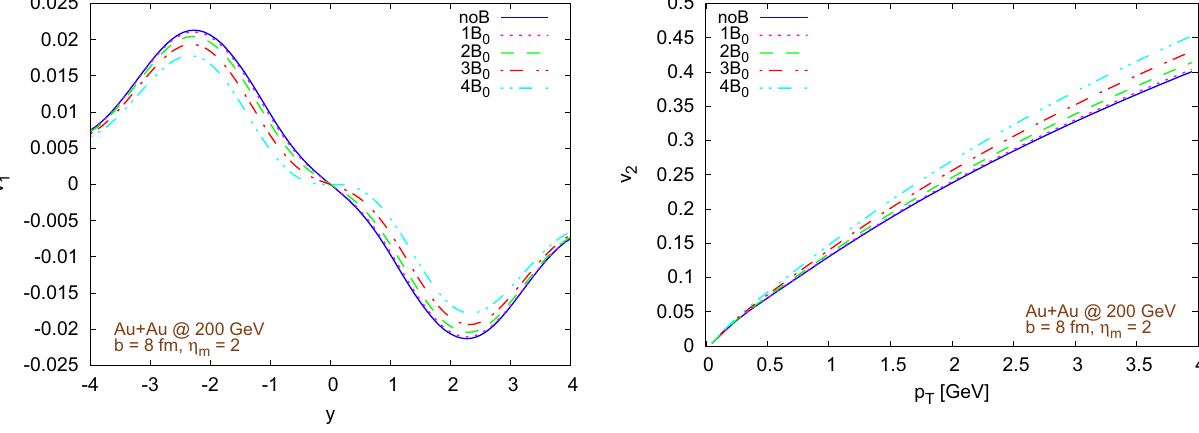
Fig. 5 Effect of the magnitude of the initial magnetic field on v 1 ( y ) (left) and v 2 ( p T , y = 0 ) (right) in Au+Au collisions at with b = 8fm, when considering a tilted initial energy density distribution (see App. B1) with parameter η m =